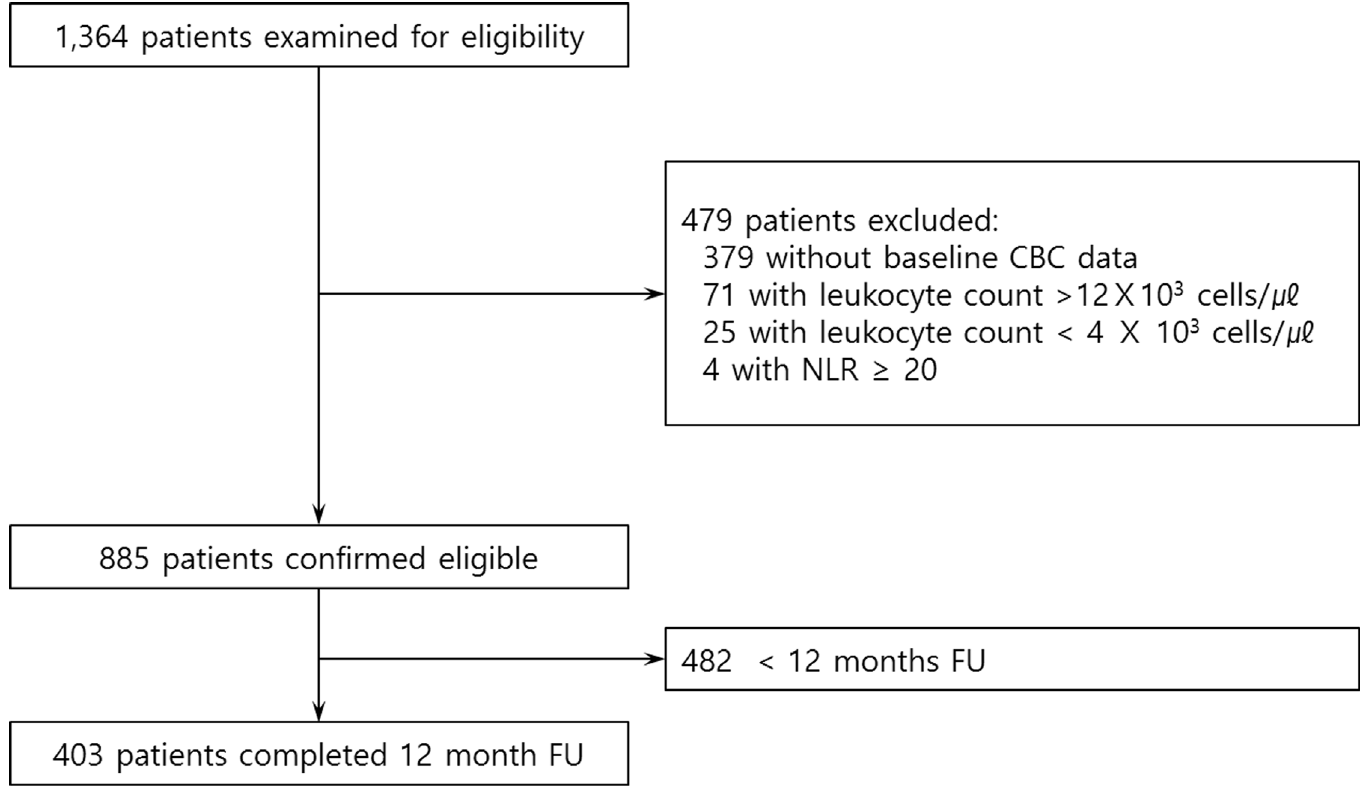
Fig 1. Study flow